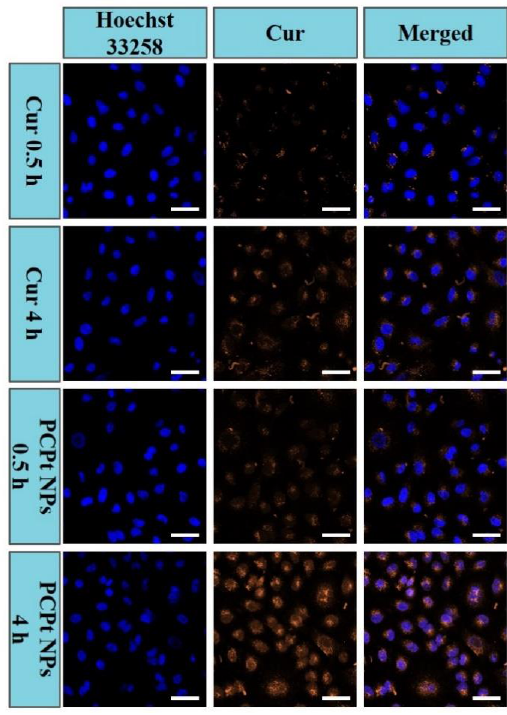
Figure 6. Cellular uptake and intracellular distribution of Cur in HeLa cells observed by using CLSM after 0.5 and 4 h incubation of free Cur and PCPt NPs (Scale bar: 50 μm). Accordingly, the quantitative analyses of the cellular uptake against HeLa cells were determined by flow cytometry (Figure 7). The PCPt NPs presented a stronger fluorescence level than free Cur after incubation for 4 h. The results were consistent with CLSM results, and they further demonstrated that the PCPt NPs could be rap- idly internalized and release the drugs into cytoplasm. Figure 7. Flow cytometry analysis of HeLa cells treated with free Cur for 1 h ( a ), PCPt NPs for 1 h ( b ), free Cur for 4 h ( c ), and PCPt NPs for 4 h ( d ). 4. Conclusions In summary, a backbone-type platinum (IV) and Cur containing mPEG- poly(platinum-co-Cur)-mPEG (PCPt) copolymer was designed and synthesized by